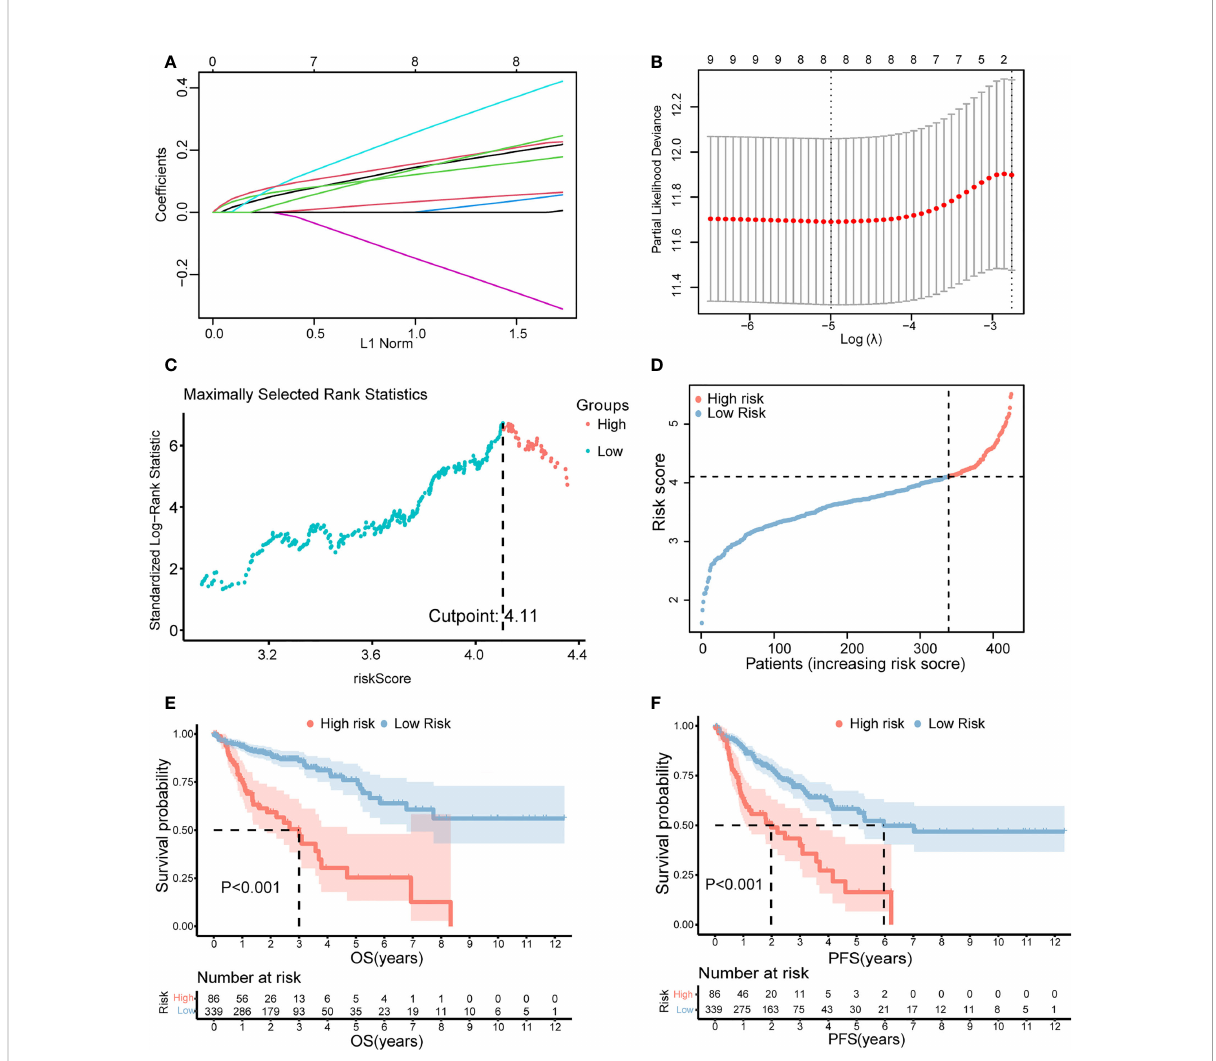
FIGURE 3 Establishment of the risk score by LASSO regression analysis. (A) LASSO coef fi cient pro fi les of the eight genes in colon cancer samples. (B) A coef fi cient pro fi le plot was generated against the log (lambda) sequence. Selection of the optimal parameter (lambda) in the LASSO model for colon cancer. (C) The optimal cutoff value was determined to maximize log-rank statistic. (D) The distribution and cutoff value of the risk scores in the TCGA cohort. Kaplan – Meier curves for the OS (E) and PFS (F) of patients in the high- and low-risk groups in the TCGA cohort. LASSO, least absolute shrinkage and selection operator; TCGA, The Cancer Genome Atlas; OS, overall survival; PFS, progression-free